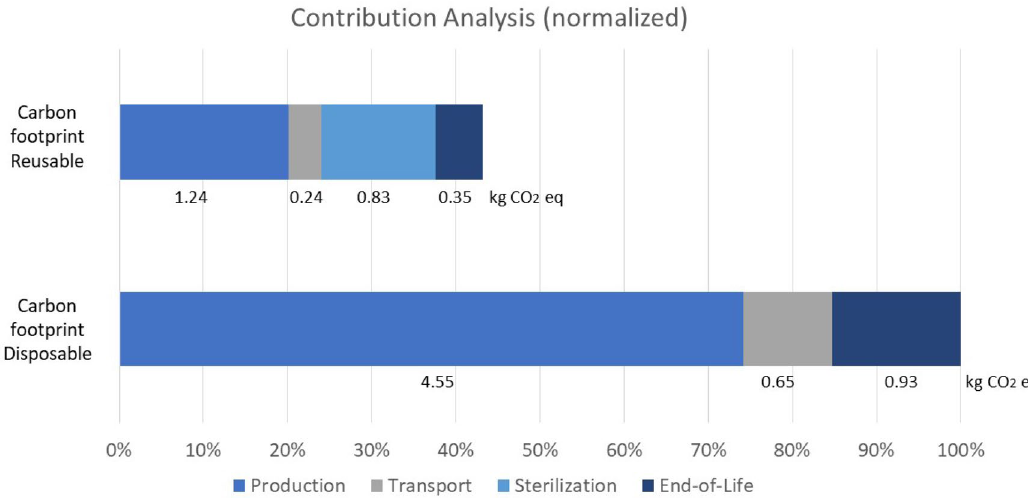
Figure 2. Sources of impact relative to the impact category carbon footprint.